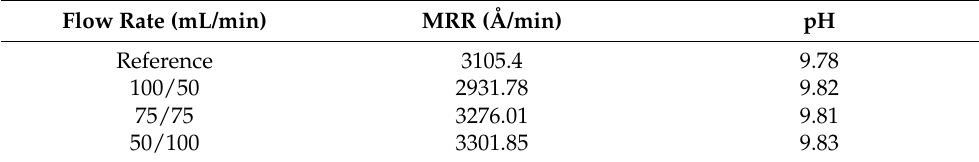
Figure 3. ( a ) Position of the two way injection;H 2 O 2 -slurry ( b ) MRR of the reference and the two- injection with position; H 2 O 2 -slurry. way injection with position; H 2 O 2 -slurry. Table 2. MRR and pH of reference and the two-way injection with position; H 2 O 2–